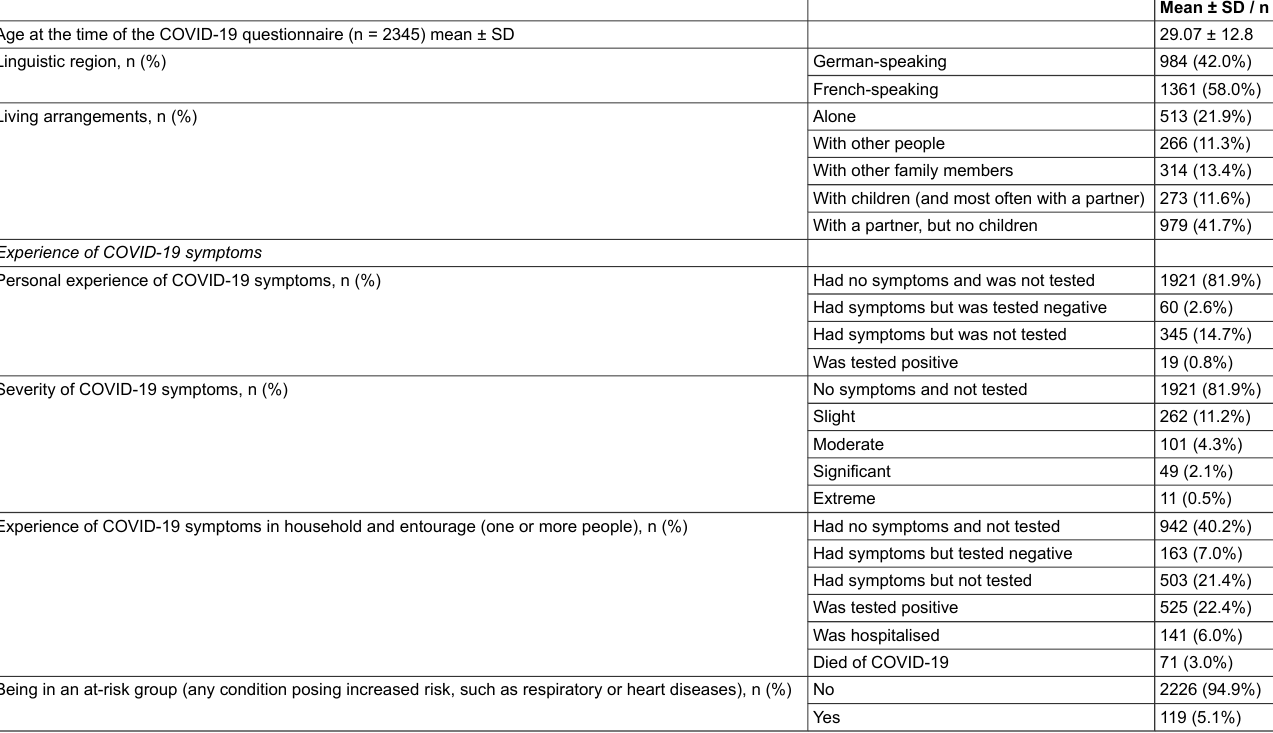
Table 1: Demographic characteristics of the sample (total n = 2345). Age at the time of the COVID-19 questionnaire (n = 2345) mean ± SD